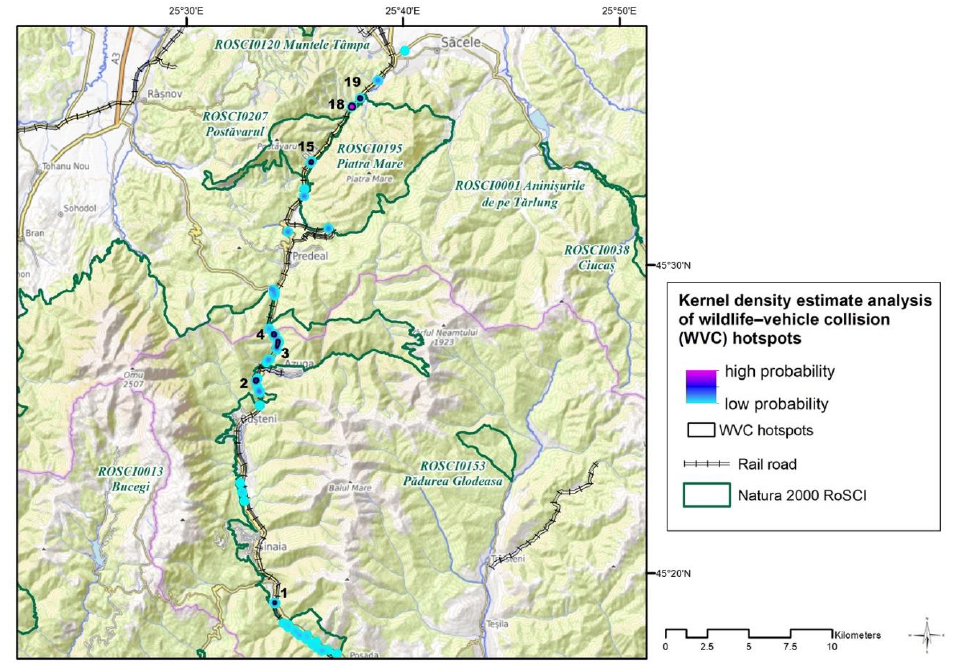
Figure 2. Model-based estimation of collision risk for Prahova Valley (DN1). High probability is represented in purple, and the WVC hotspot is dark circled.